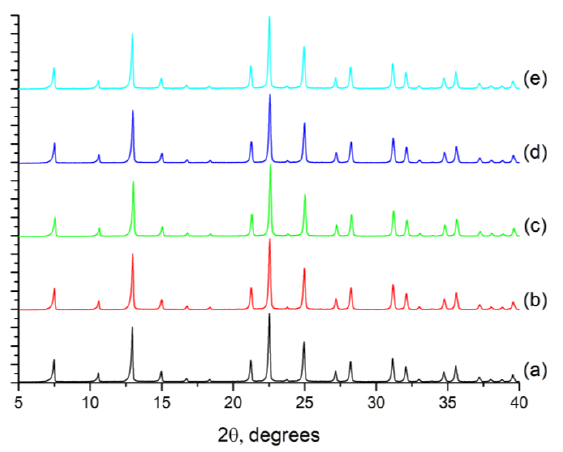
Figure 1. X-ray diffraction patterns of: ( a ) reference ITQ-29 zeolite, prepared as described in [24]; and samples synthesized in this work under different conditions for the use as seeds: ( b ) dynamic synthesis, 3.5 days; ( c ) dynamic synthesis, 4.5 days; ( d ) static synthesis, 3.5 days; ( e ) static synthesis, 4.5 days.